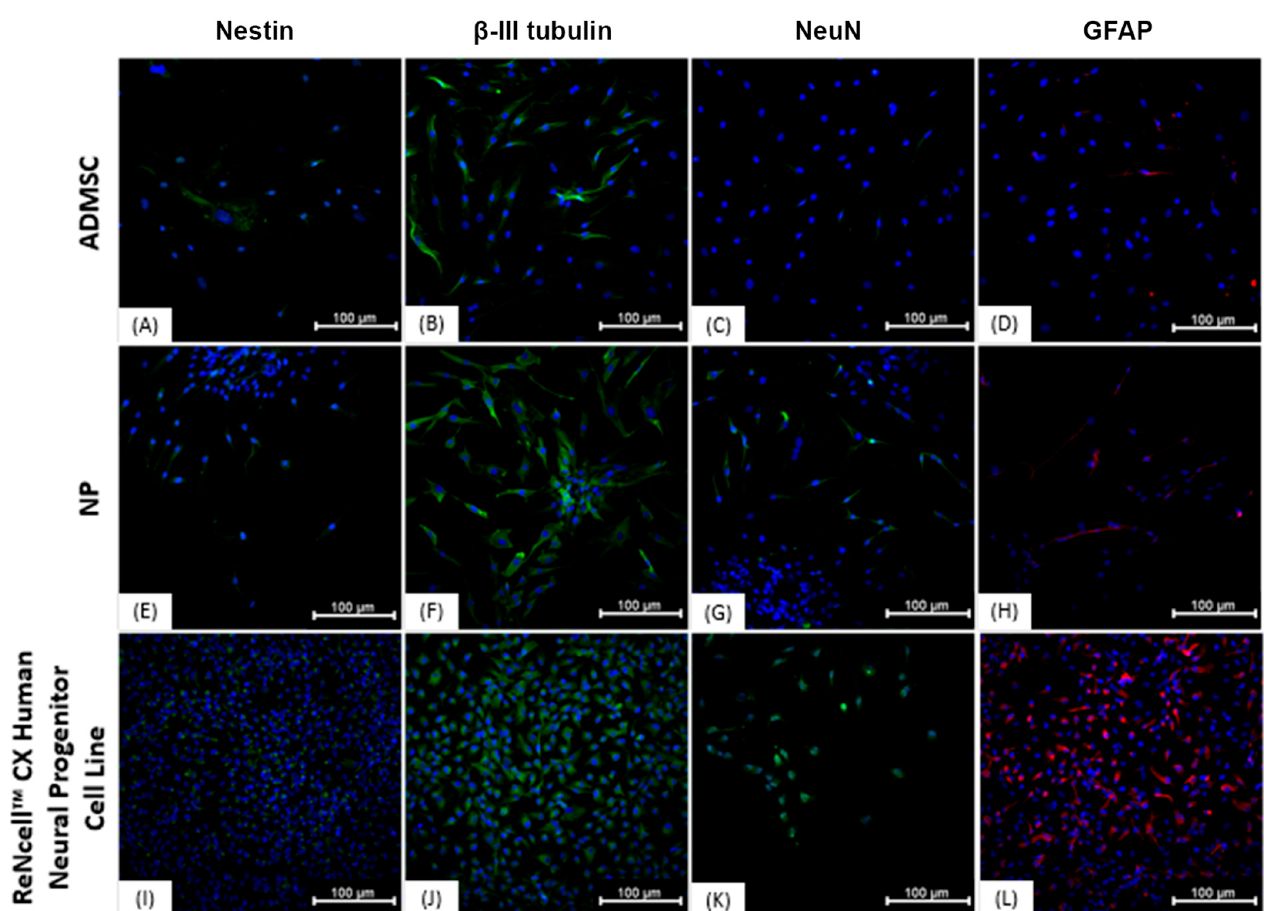
Figure 4. Immunocytochemistry of the ADMSCs, NPs and ReNcell™ CX. ( A ) ADMSCs labeled with anti-nestin antibody (FITC—green) and Hoechst (blue); ( B ) ADMSCs labeled with anti- β -III tubulin antibody (FITC—green) and Hoechst (blue); ( C ) ADMSCs labeled with anti-NeuN antibody (FITC—green), and Hoechst (blue); ( D ) ADMSCs labeled with anti-GFAP antibody (Cy5—red), and Hoechst (blue); ( E ) NPs labeled with anti-nestin antibody (FITC—green) and Hoechst (blue); ( F ) NPs labeled with anti- β -III tubulin antibody (FITC—green) and Hoechst (blue); ( G ) NPs labeled with anti-NeuN antibody (FITC—green) and Hoechst (blue); ( H ) PNs labeled with anti-GFAP antibody (Cy5—red) and Hoechst (blue); ( I ) ReNcell™ CX labeled with anti-nestin antibody (FITC—green) and Hoechst (blue); ( J ) ReNcell™ CX labeled with anti- β -III tubulin antibody (FITC—green) and Hoechst (blue); ( K ) ReNcell™ CX labeled with anti-NeuN antibody (FITC—green) and Hoechst (blue); ( L ) ReNcell™ CX labeled with anti-GFAP antibody (Cy5—red) and Hoechst (blue); Images obtained with IN Cell Analyzer 2000, GE (20 × ). Scale bar, 100 µ m. ADMSCs, adipose-derived mesenchymal stem cells; NPs, neural precursors.